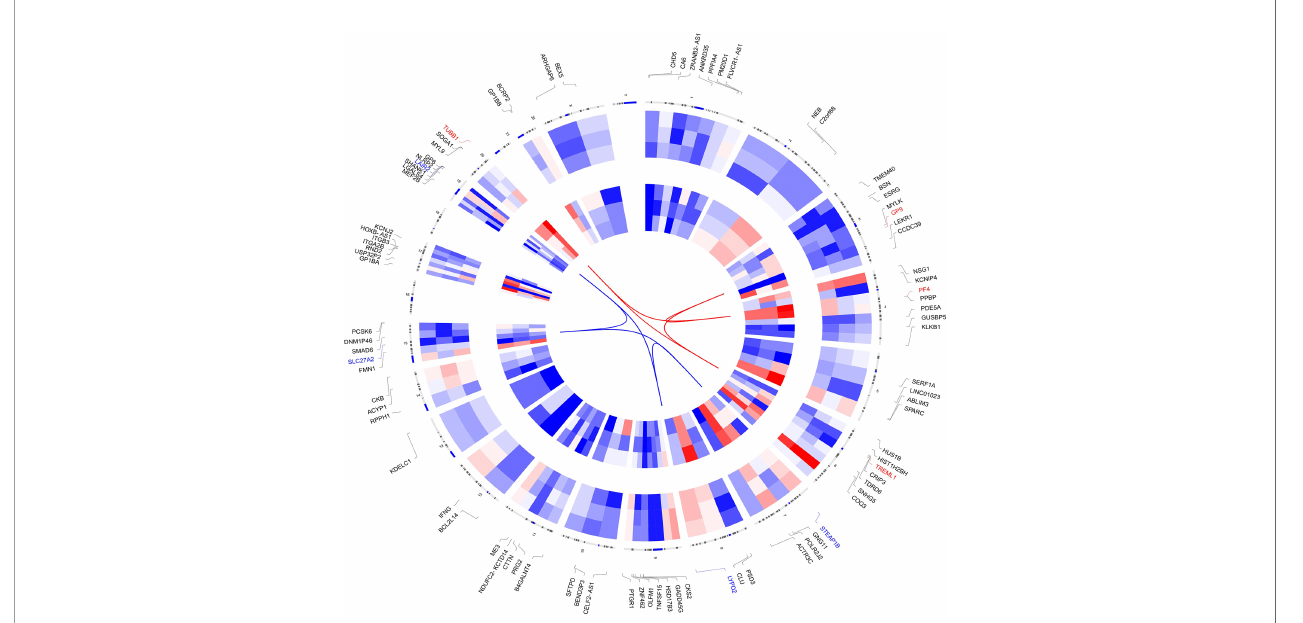
FIGURE 2 | Circos plot of expression patterns and chromosomal positions of top 100 differentially expressed genes (DEGs). The outer circle represents chromosomes, and lines coming from each gene point to their speci fi c chromosomal locations. The group of patients is represented in the inner circular heatmaps. According to |log 2 fold change|, the top four upregulated genes (red) and the top four downregulated genes (blue) are connected with red and blue lines in the center of the Circos